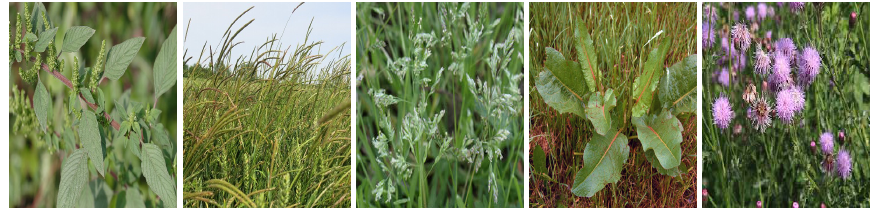
Figure 1. From left to right: Pigweed, Blackgrass, Bluegrass, Dockleaf, Canadian Thistle (Source: